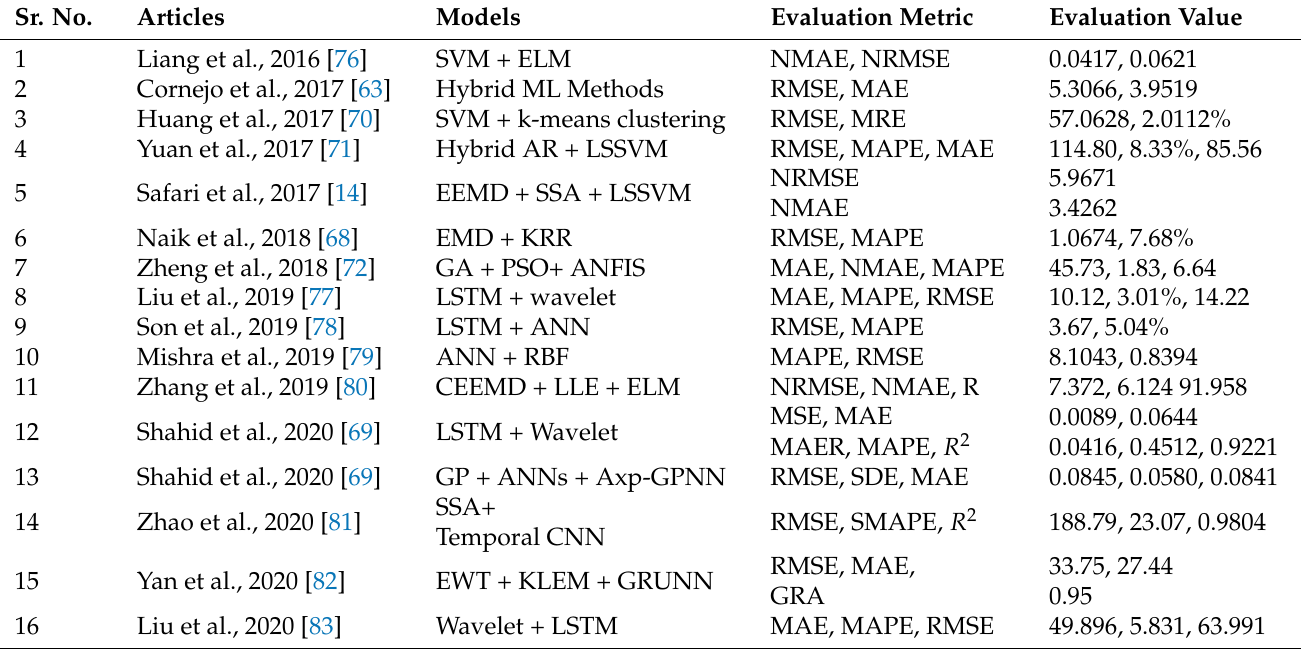
Table 8. Hybrid methods for short-term